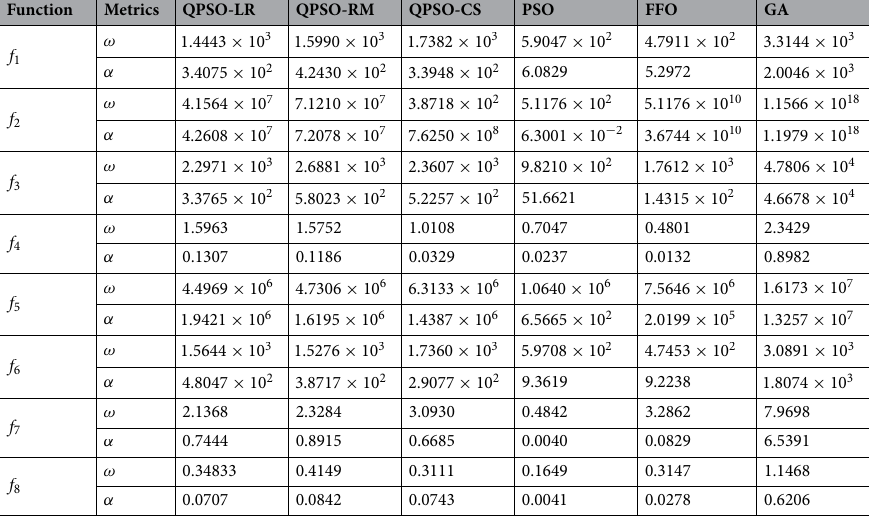
Function Metrics